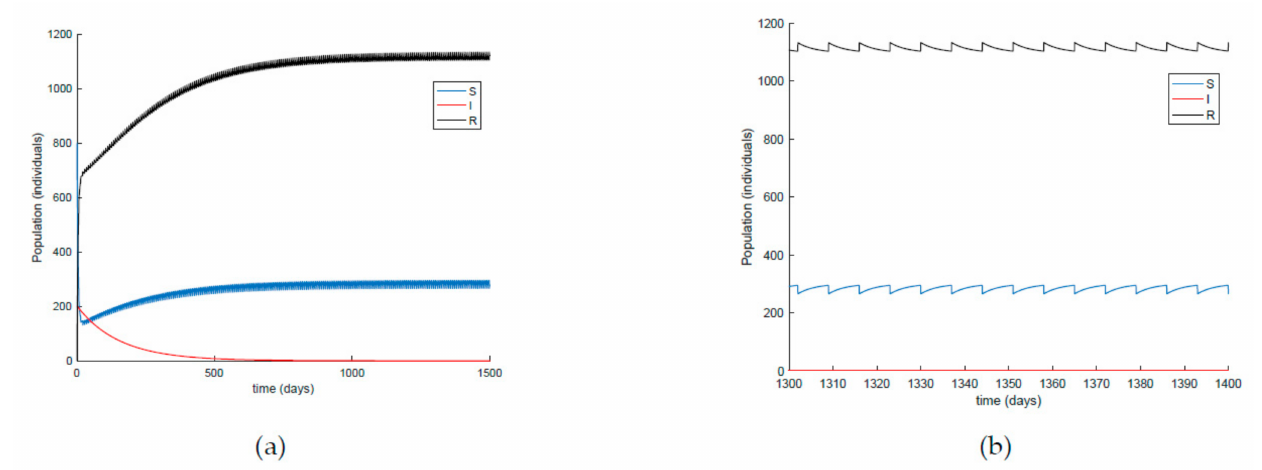
Figure 21. ( a ) Extended simulation time in Figure 14 and ( b ) zoomed image of the final time period for the susceptible and recovered individuals.